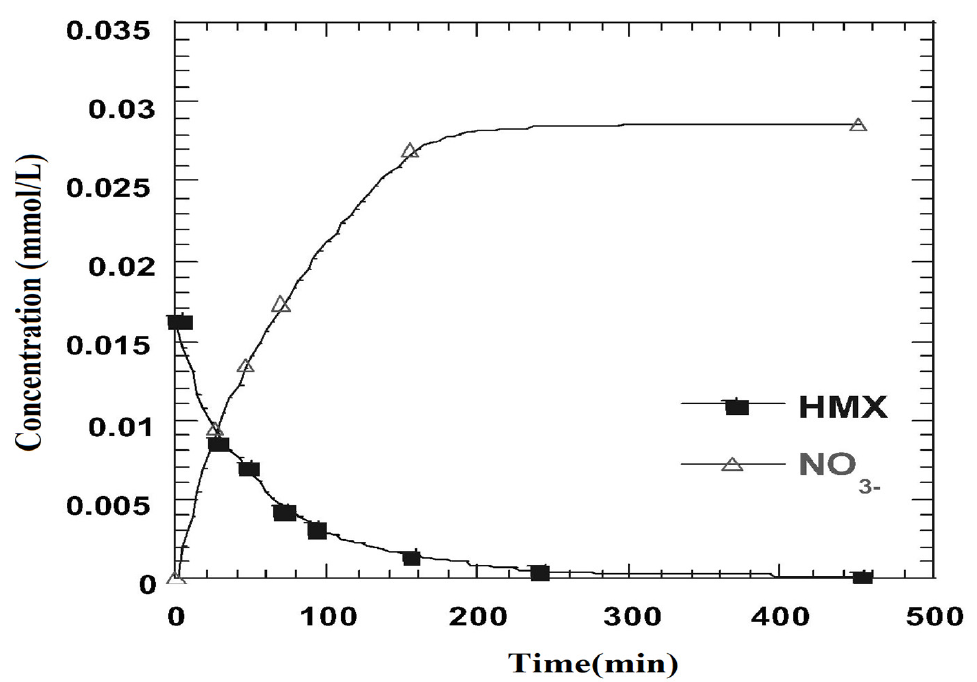
Figure 3. HMX degradation kinetics by Fenton oxidation. Adapted from Ref. [30] with permission from Elsevier.